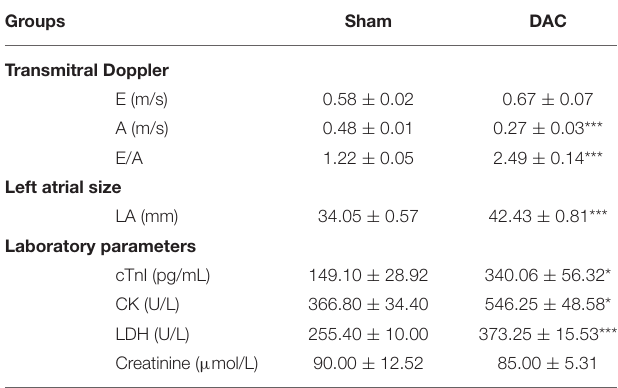
TABLE 2 | Indices of heart failure of the sham and DAC groups.